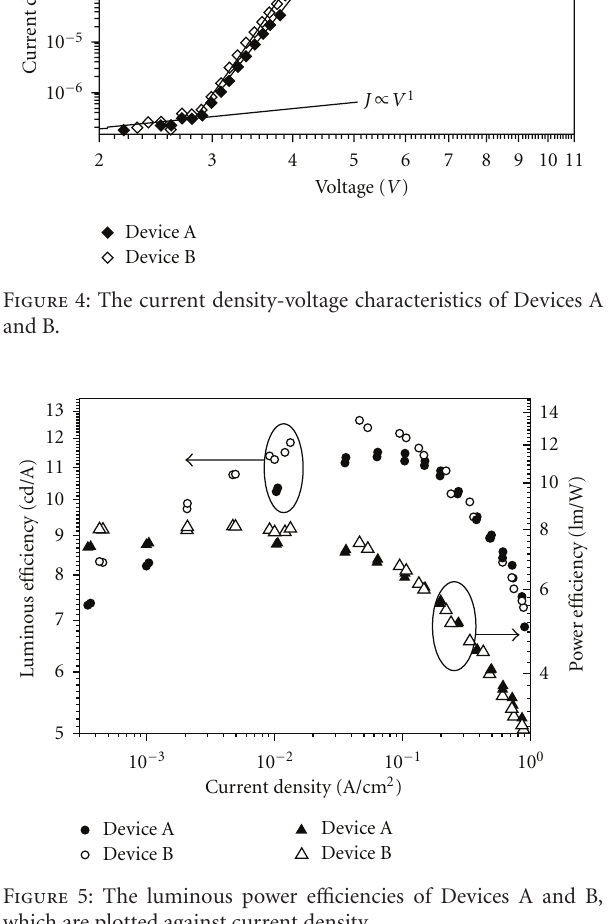
Figure 7: The lifetime performance of Devices A and B, which were obtained at initial luminance of 2500cd/m 2 (the luminance is normalized at the initial